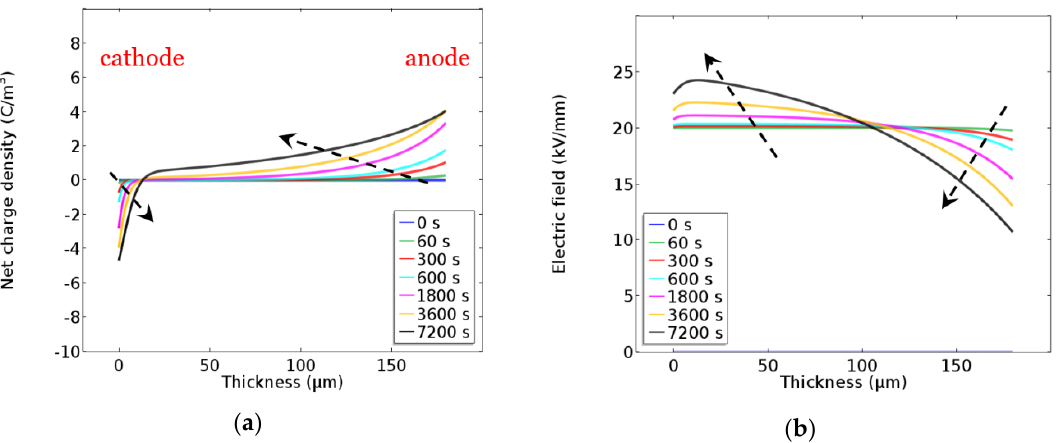
Figure 8. ( a ) The simulated space charge distribution in the LDPE sample at 20 kV / mm field. ( b ) Calculated electric field distribution over the thickness of LDPE film.